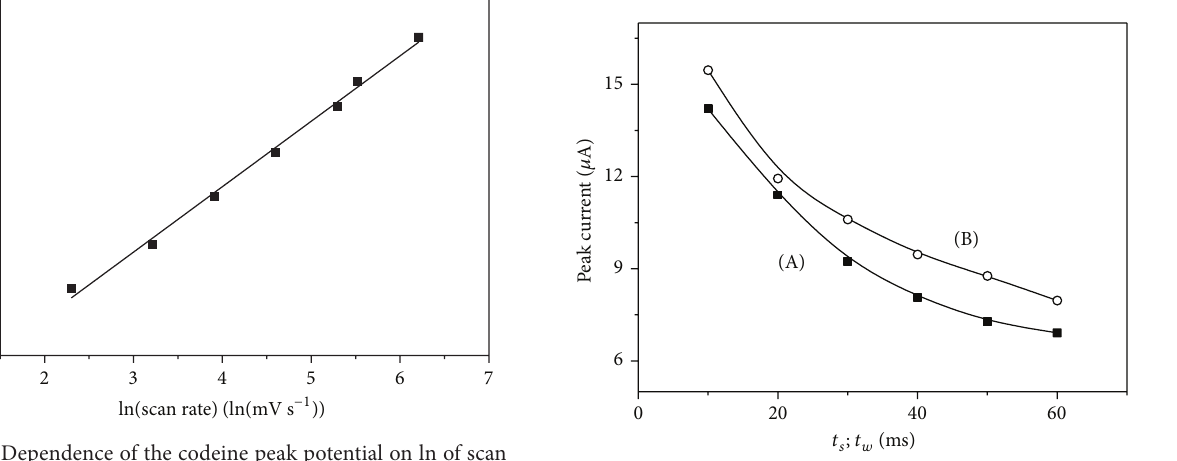
Figure 4: Dependence of the peak current on sampling (A) and waiting time (B) in the range of 10 to 60 ms for 10 𝜇 M codeine in 0.1 M phosphate buffer (pH 3.0) volume of Nafion/MWCNTs 10 𝜇 L. Other instrumental parameters: Δ𝐸 = 50mV, 𝐸 𝑠 = 5 mV, preconcentration potential 300 mV, preconcentration time 20 s, and stirring rate 500